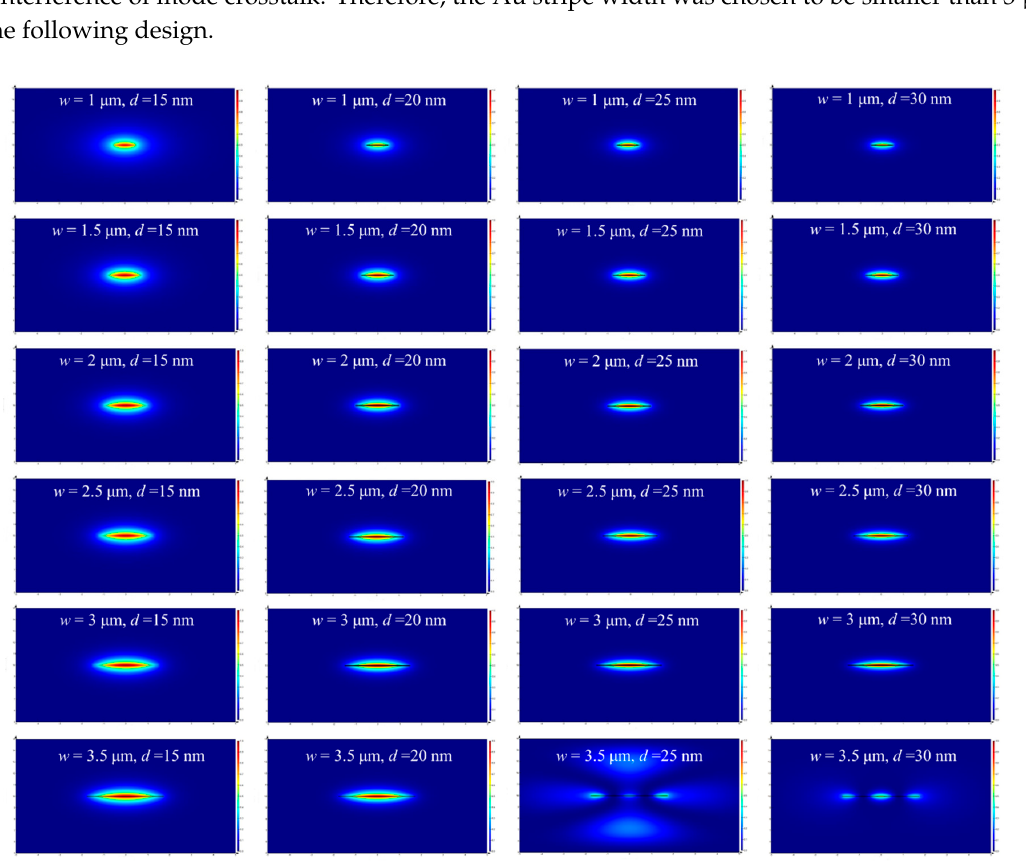
Figure 2. Electric field spatial distribution of Au stripe waveguide when the width w = 1, 1.5, 2, 2.5, 3, 3.5 μ m and d = 15, 20, 25, 30 nm, respectively. 3.5 µ m and d = 15, 20, 25, 30 nm,